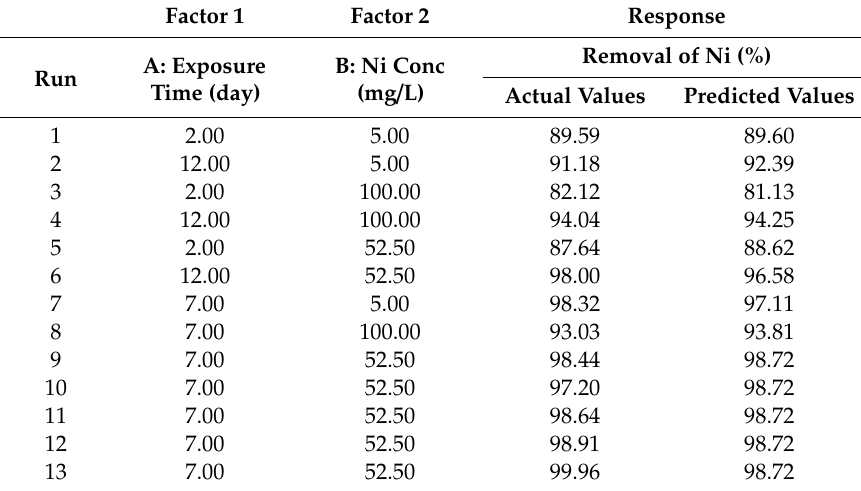
Table 2. Central composite design (CCD) and experimental results.